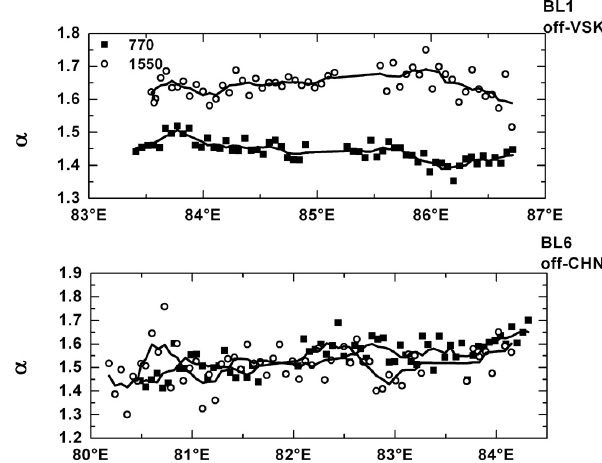
Fig. 14. Latitude profile of surface wind speeds as derived from Quikscat satellite data on the sortie days of BL3 and BL5. The arrow in the figure indicates the latitude of PBR.